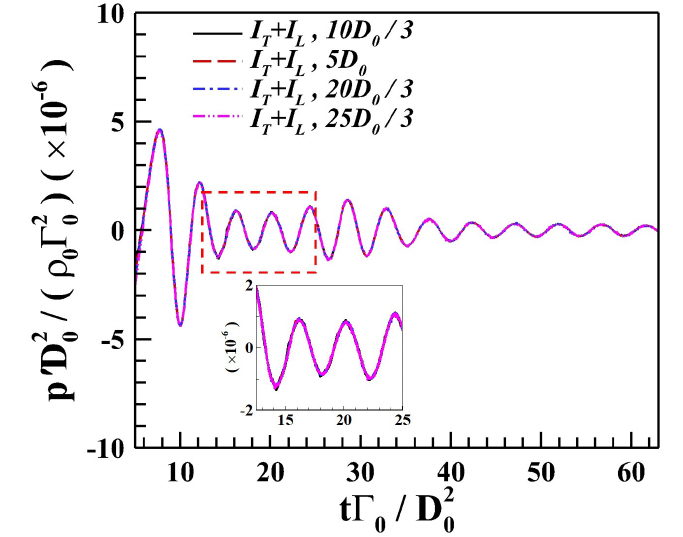
Figure 11. Acoustic pressure calculated by summing Equations (8) and (4) when filtering the spurious mass flux at the observer 1250 D 0